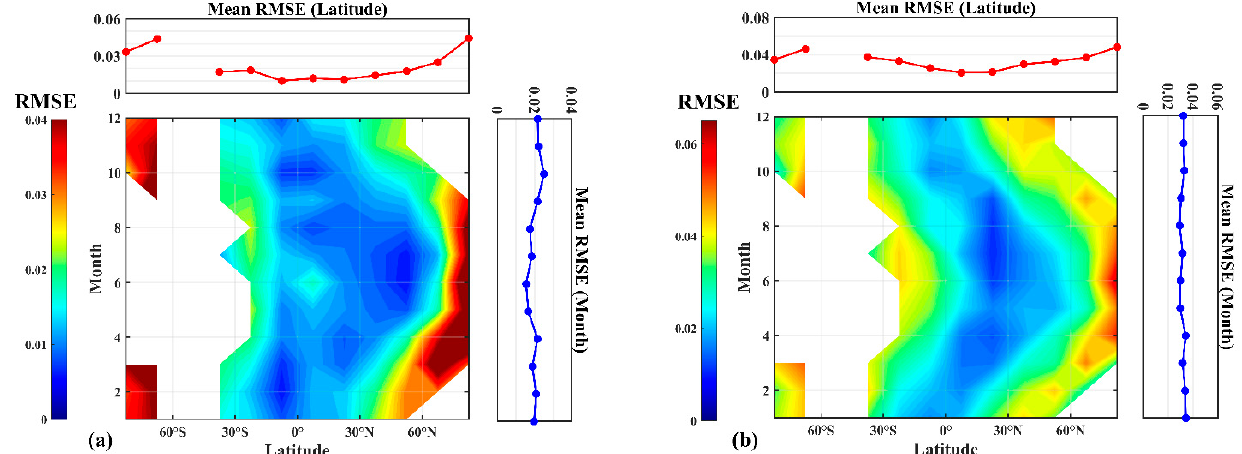
Figure 5. Comparison of the fitting residuals of the RTLSR model at different latitudes and months in the red ( a ) and NIR ( b ) bands. The colored bars represent RMSE values. The mean RMSE variation in different latitudes and months in the two bands are shown in the line plots above and to the right of the heatmaps,